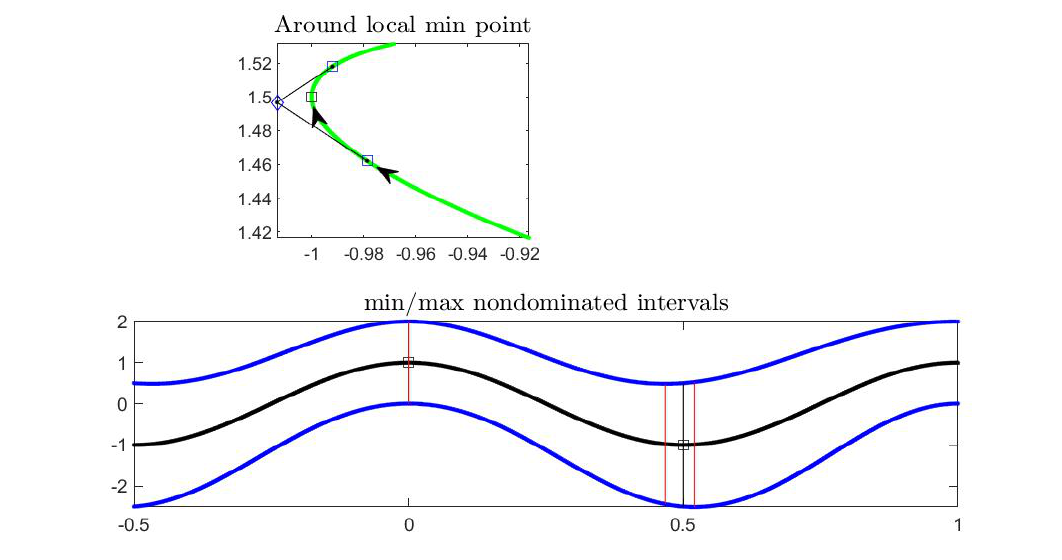
Figure 6. Efficient frontiers for min and max points of F ( x ) in Example 2. The top picture shows the efficient frontier for x m with the tangent lines to the curve F . In the bottom picture, the efficient frontiers are delimited by vertical red segments containing the min and max points (the max point is lattice type